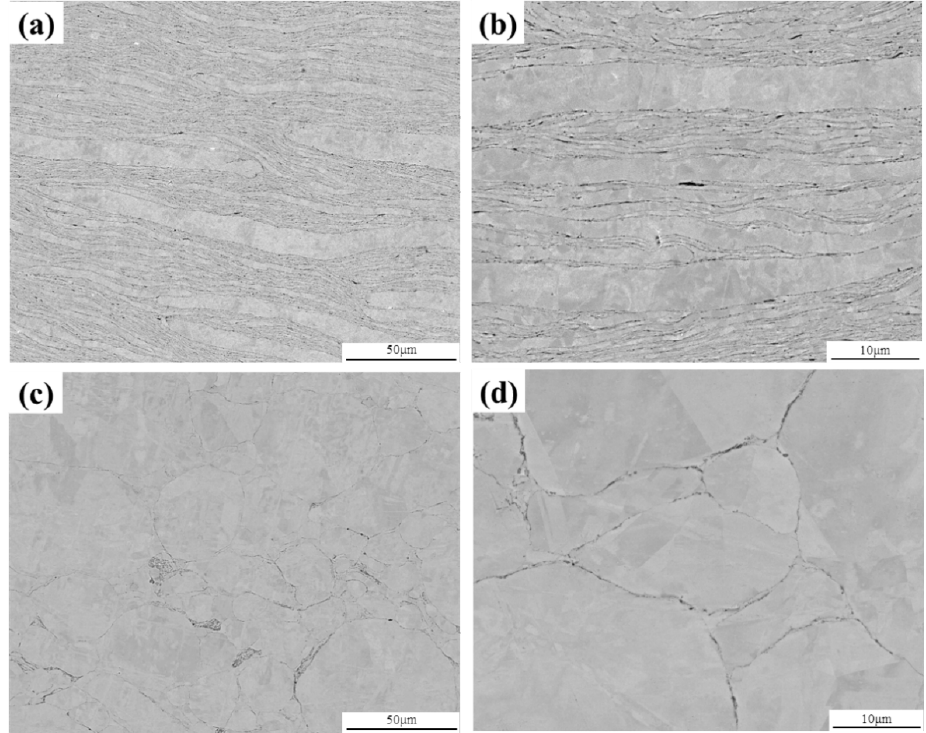
Figure 3. SEM images of a GNPs/Cu–Cr–Mg composite and the Cu–Cr–Mg matrix; ( a ) low magni- fication SEM image of the composite, ( b ) high magnification SEM image of the composite, ( c ) low magnification SEM image of the Cu–Cr–Mg matrix, and ( b ) high magnification SEM image of the Cu–Cr–Mg matrix.